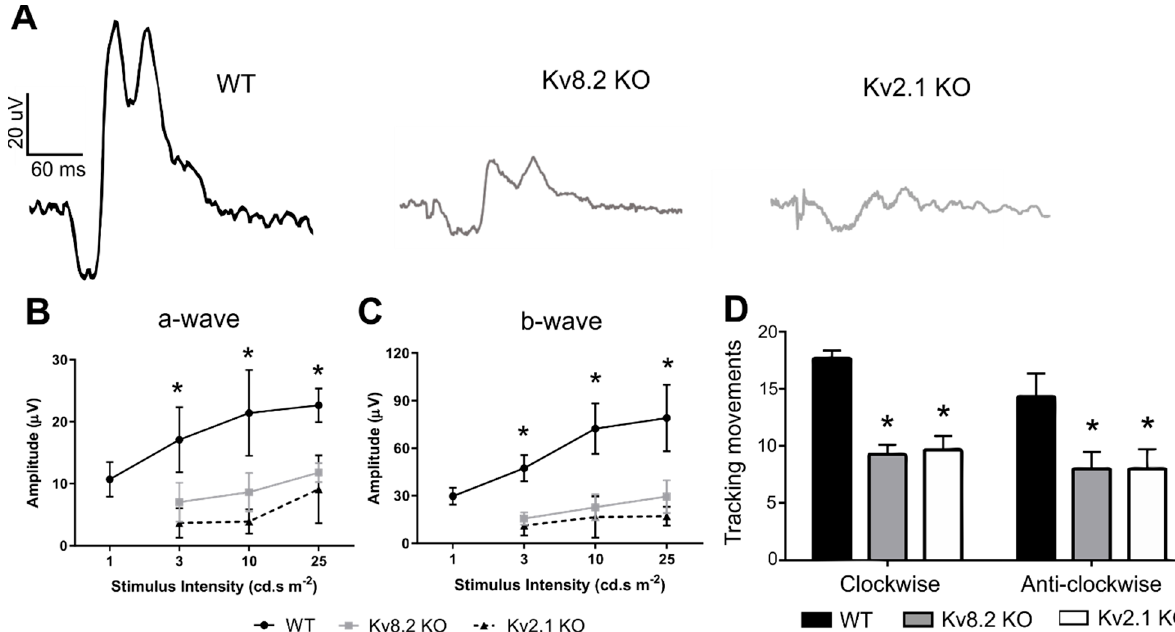
Figure 6. Photopic visual response from Kv deficient retinas. ( A ) Representative light-adapted photopic full flash ERG traces from wild type (WT), Kv8.2 knockout (KO) and Kv2.1 KO animals taken at 25 cd.s/m 2 . ( B ) Quantification of photopic a-wave in all three genotypes at different stimulus intensities. * denote significance between the Kv lines and WT with p < 0.0005. No statistical difference was observed between the Kv8.2 and Kv2.1 KO lines. ( C ) Quantification of photopic b-wave in all three genotypes at different stimulus intensities. * denote significance between the Kv lines and WT with p < 0.0005. No statistical difference was observed between the Kv8.2 and Kv2.1 KO lines. ( D ) Light-adapted photopic optomotor response from all three genotypes. Y -axis shows tracking movements per 2 min. * p < 0.002 compared to WT. Results for ( B – D ) are presented as mean +/ − SD from n = 3–4 animals (6 eyes per genotype). Significance was obtained through a two-way ANOVA and Tukey’s multiple comparison test post hoc.